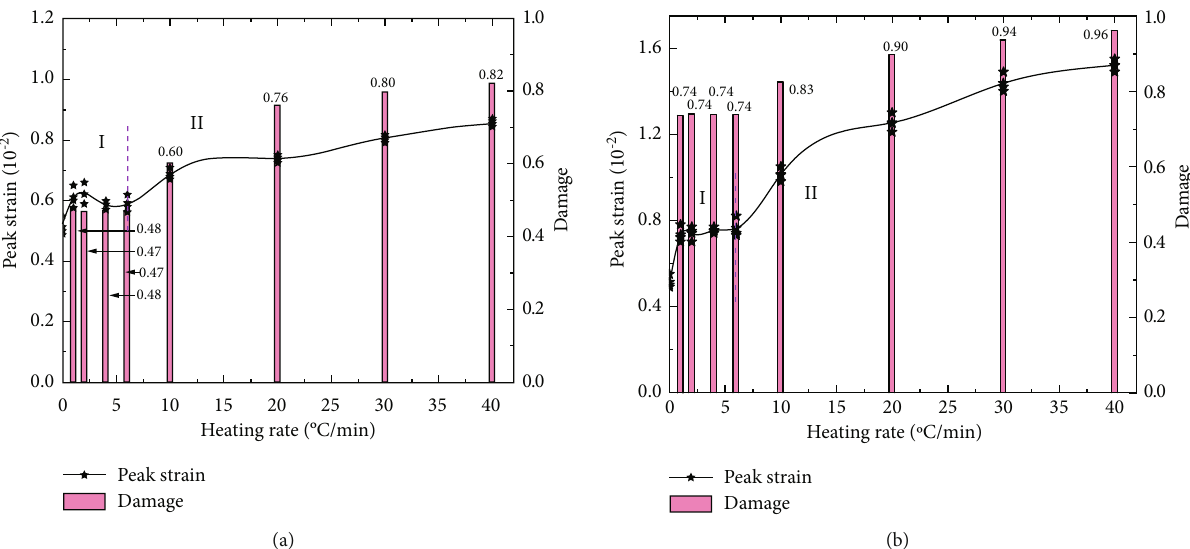
Figure 11: Damage e ff ect on the peak strain of thermal shock treated granite specimens (a) T = 400 ° C and (b) T = 600 ° C .